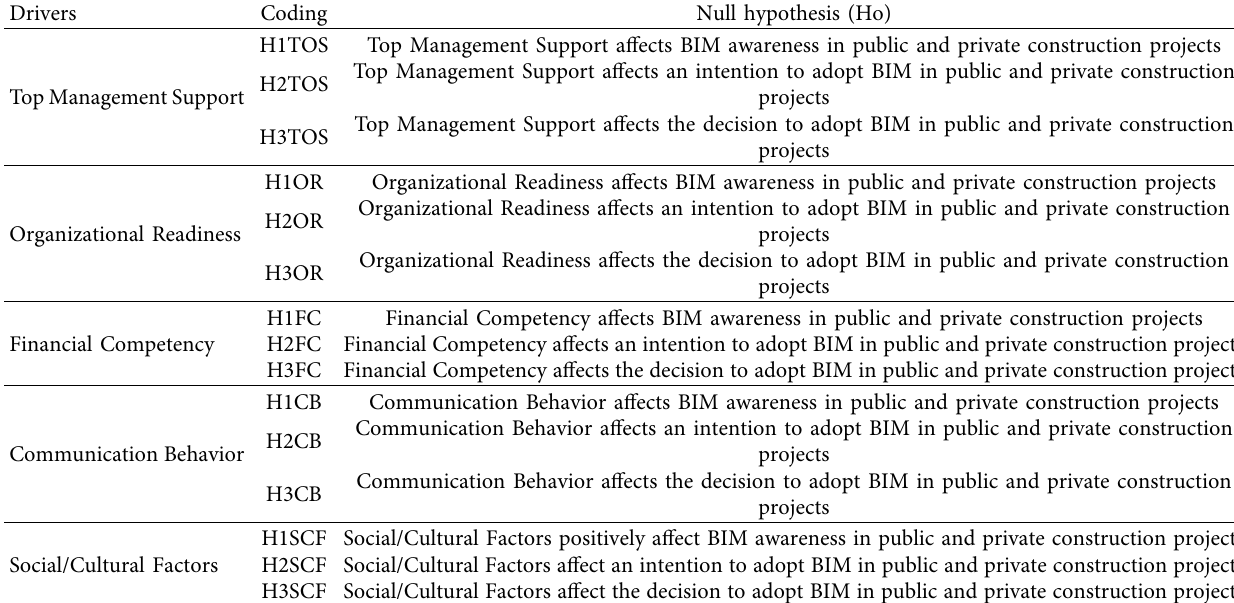
Table 3: Hypothesis about the effect of organizational aspects in public and private sectors across all adoption stages. Drivers